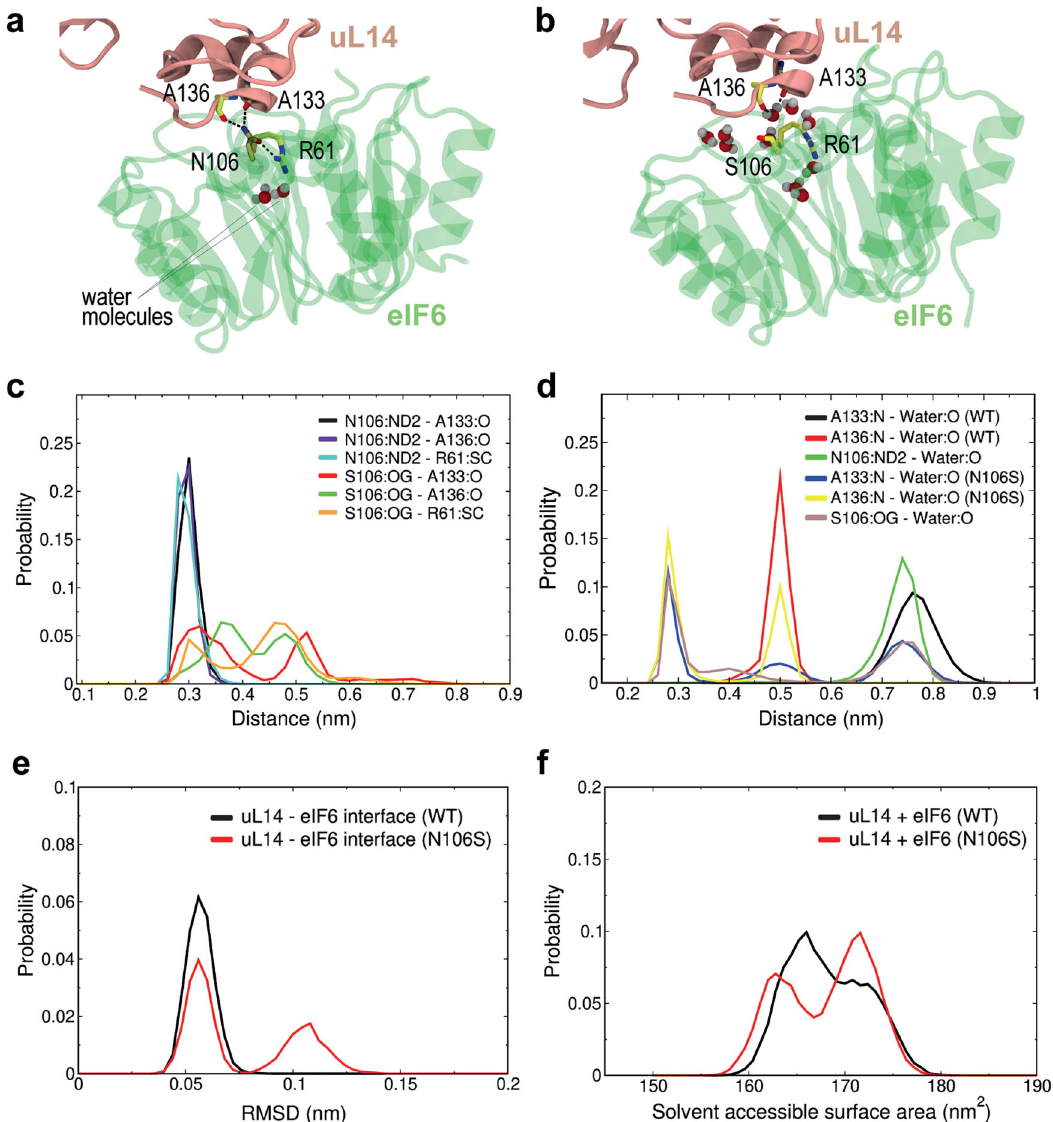
Fig. 6 N106S mutation disrupts the H-bonding capacity of the eIF6-uL14 interaction interface. a , b Representative snapshots of the interaction interface between eIF6 N106 WT or S106 mutant (green) and uL14 (salmon) after 500 ns of simulation. Key water molecules are indicated in CPK format. c , d Distances (nm) between the indicated atoms of eIF6 WT and mutant (residues N106, S106, and R61), and either uL14 (residues A133, A136) ( c ) or water ( d ). e Root mean square deviation (RMSD) of the distance (nm) between the WT or mutant eIF6 inner ring and uL14. f Solvent accessible surface area of the WT or mutant eIF6-uL14 complex. Curves in each plot include data from 5 replicas. “ SC ” , sidechain atoms NH1 and NH2 of the R61 guanidinium